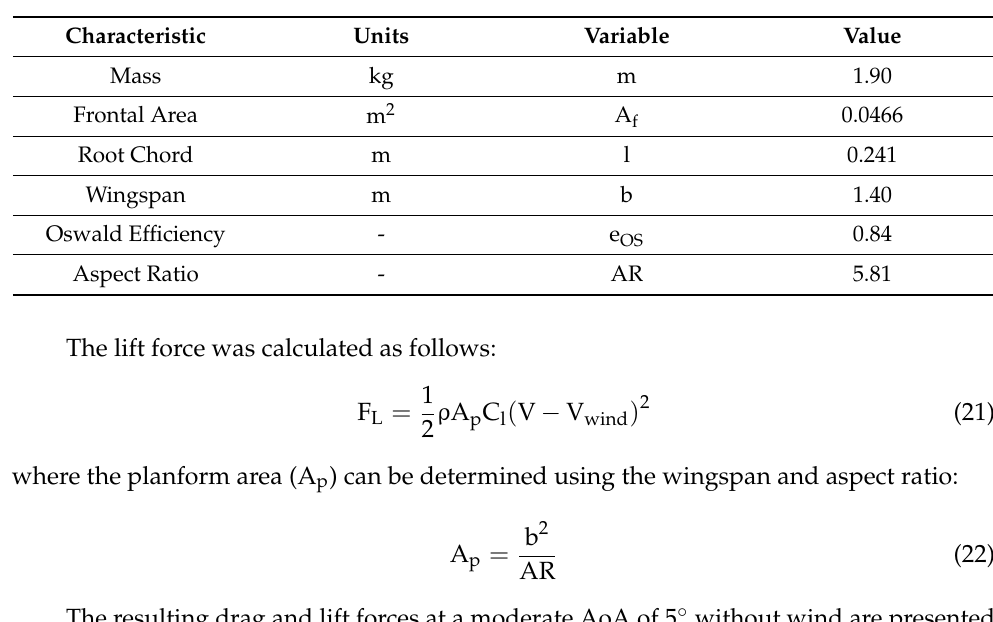
Table 4. RQ-11B Raven salient